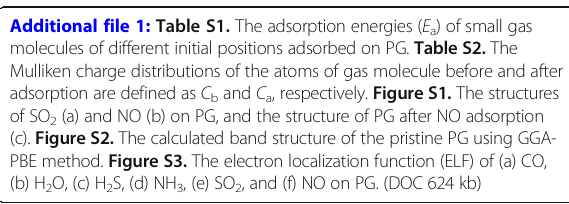
PBE method. Figure S3. The electron localization function (ELF) of (a) CO, (b) H 2 O, (c) H 2 S, (d) NH 3 , (e) SO 2 , and (f) NO on PG. (DOC 624 kb)